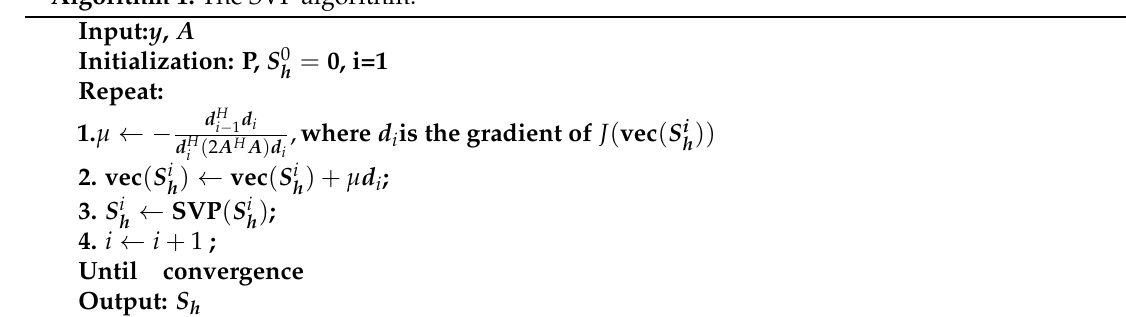
Algorithm 1: The SVP